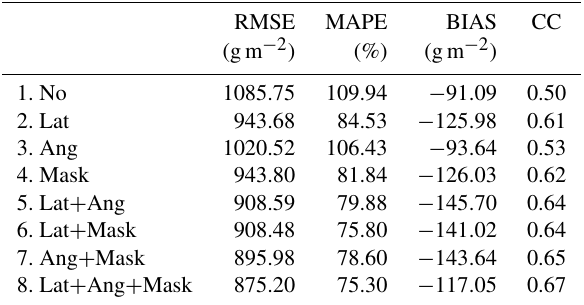
Table 3. Errors in IWP retrieval using different auxiliaries. Note: NO is for no auxiliaries, Lat is adding latitude as auxiliary informa- tion, Ang is adding the scan angle, and Mask is adding the land/sea